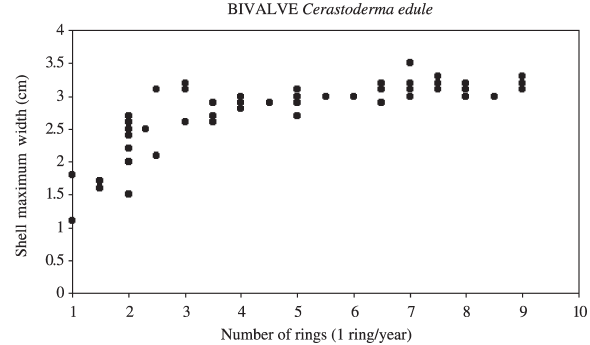
Fig . 12. – Age of cockles at Culbin Sands lagoon, from a pooled sample of 90 ind. from all sampled